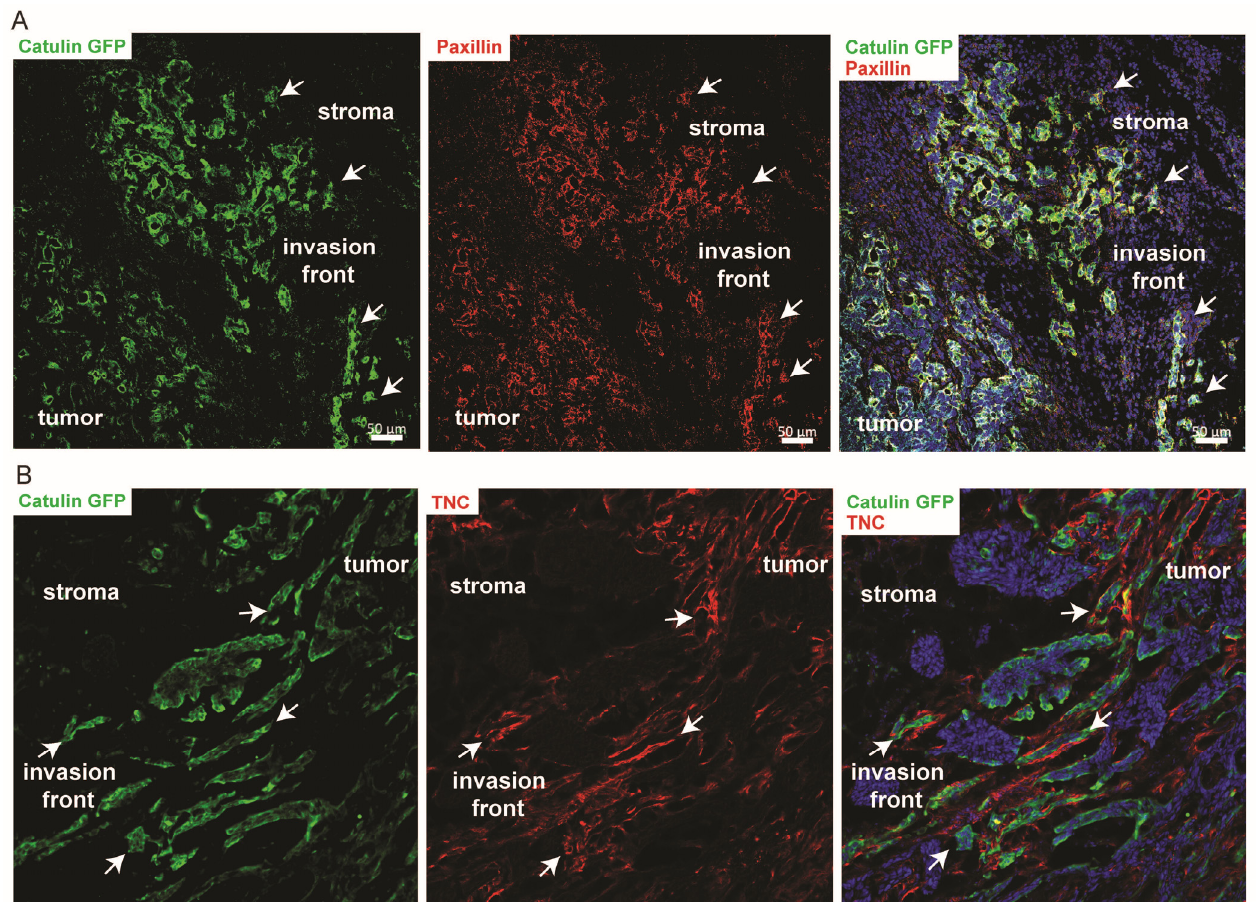
Figure 6. Cell invasion markers localization in Catulin-GFP reporter tumors. ( A ) Immunofluorescence staining of the section of tumor formed after the injection of SCC15CatGFP and the use of the paxillin antibody. GFP (catulin reporter) immunofluorescence is indicated in green, paxillin immunofluorescence is indicated in red, and DAPI (nucleus) immunofluorescence is indicated in blue. Arrows indicate cells expressing high catulin reporter and paxillin levels. Scale bar: 50 μ m. ( B ) Immunofluorescence staining of the section of tumor formed after the injection of SCC15CatGFP and the use of the tenascin C (TNC) antibody. GFP (catulin reporter) immunofluorescence is indicated in green, TNC immunofluorescence is indicated in red, and DAPI (nucleus) immunofluorescence is indicated in blue. Arrows indicate cells expressing high catulin reporter levels and tenascin C levels.